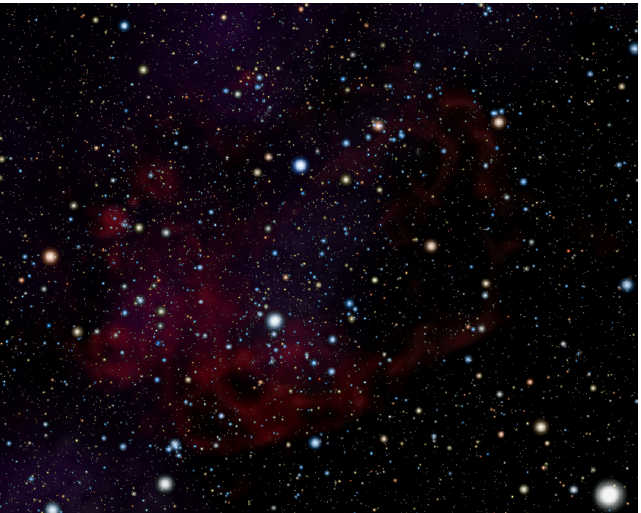
Figure 2. The Gum Nebula with the bright blue-white stars ζ Pup (upper center) and γ Vel (lower center). Image credit: Roberto